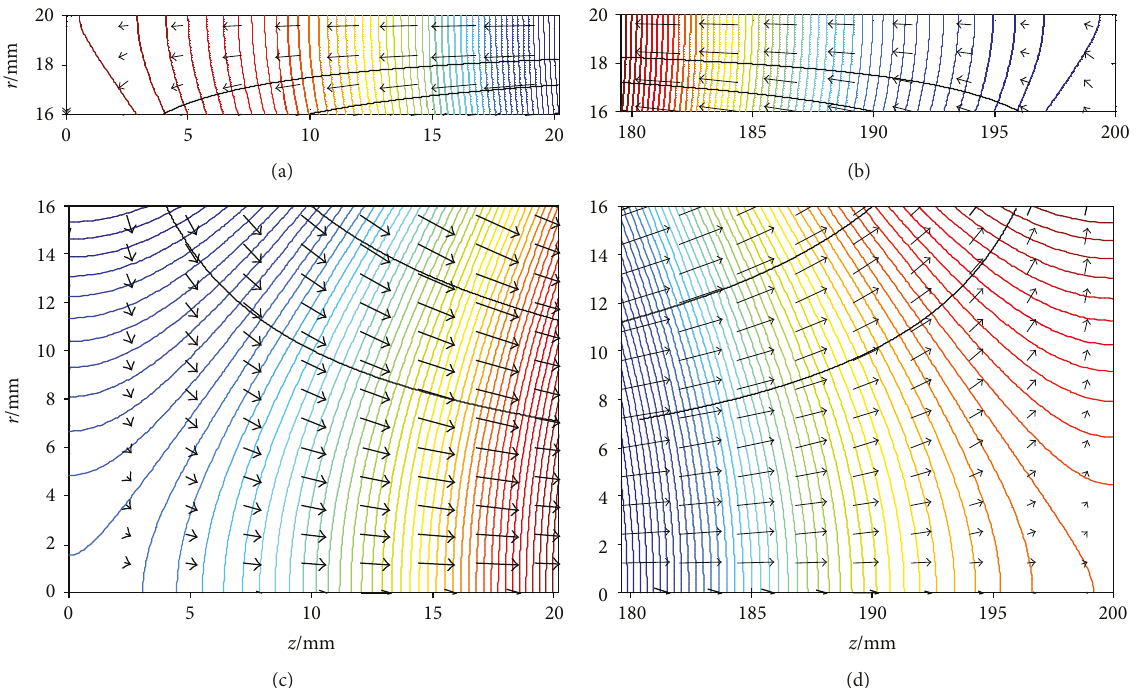
Figure 2: Potential solution of the fl ow fi eld for the case with uniform and symmetric boundary condition. (a) Liquid fi lm at the evaporator. (b) Liquid fi lm at the condenser. (c) Vapor phase at the evaporator. (d) Vapor phase at the condenser.